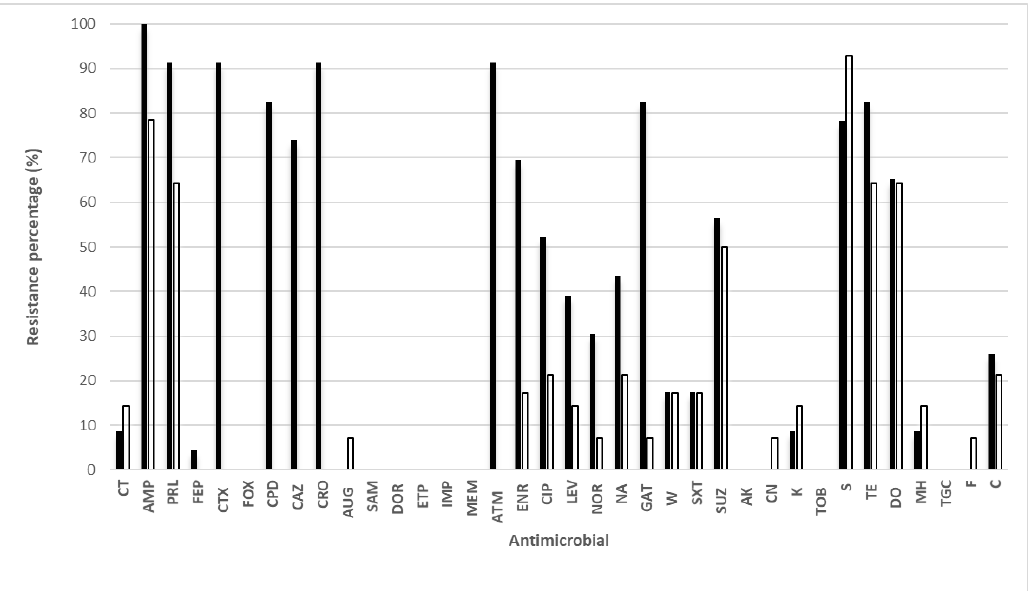
Figure 1. Antimicrobial resistance phenotype of E. coli isolated from turkey meat. CT: colistin, AMP: